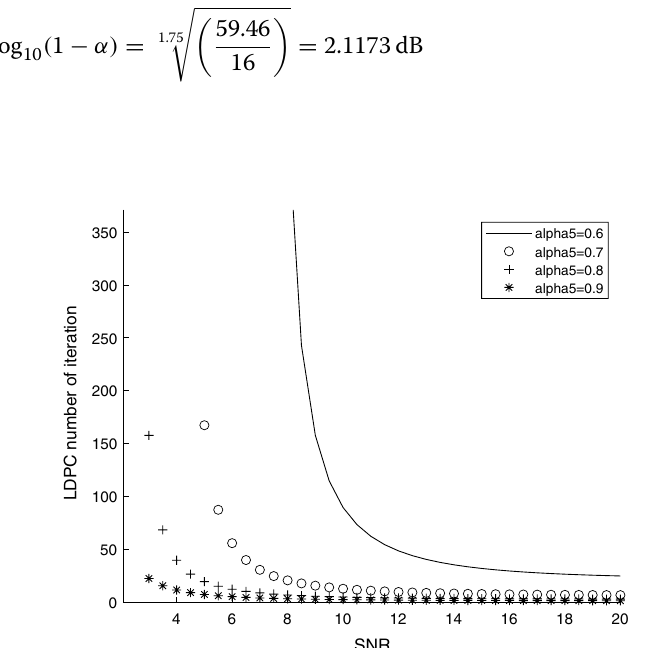
Fig. 8 Number of LDPC iteration to reach a target BER of 10 − 5 for the strongest signal after HIC-MPA